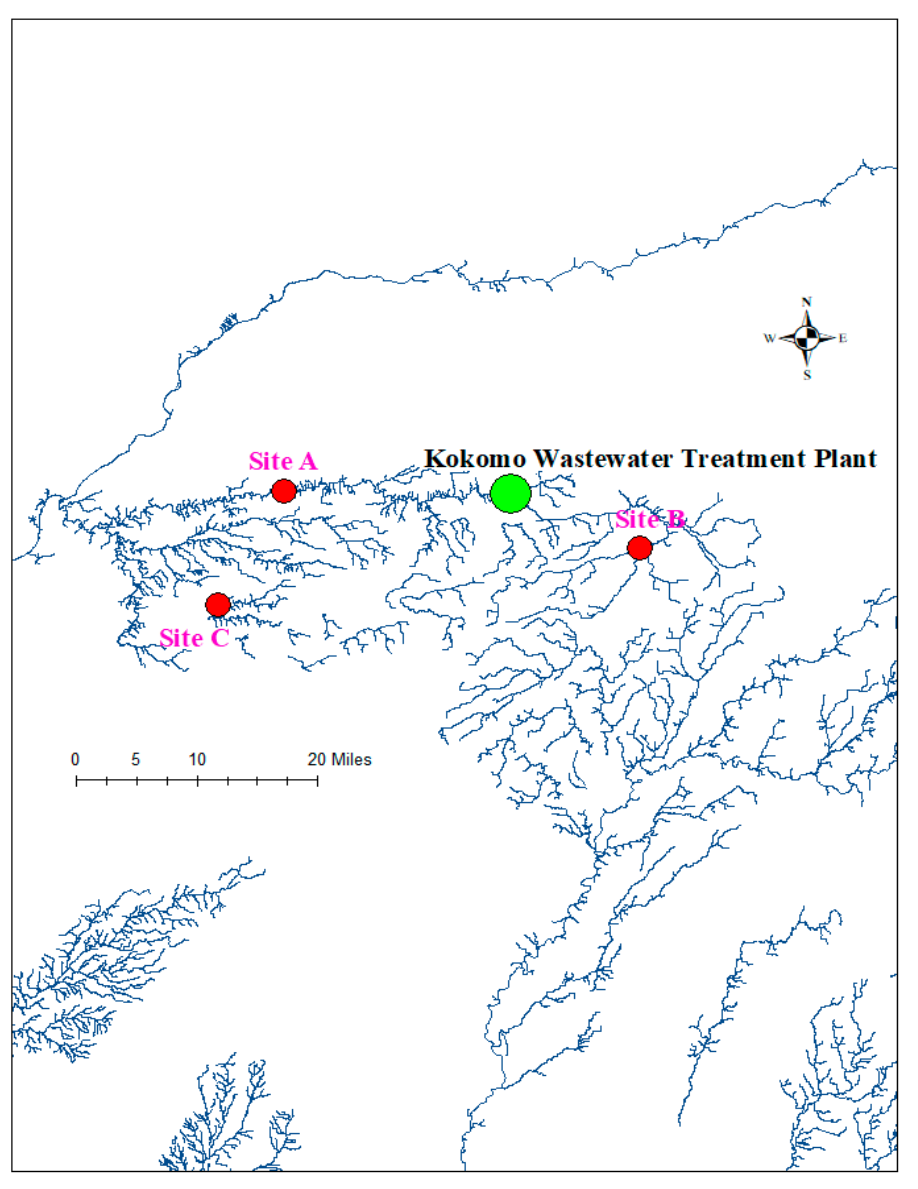
Figure 2. A map layer of impaired water bodies in Indiana. The locations of the three sampling sites within the Wildcat Creek watershed are represented by the letters A, B, and C. Site A is the Wildcat Creek (Carrol County), Site B is the Mud Creek (Tipton County), and Site C is the Kilmore Creek (Clinton County). This map was created using ArcMap in ArcGIS version 10.5.1. The map layer and associated metadata were downloaded from https://maps.indiana.edu/previewMaps/Hydrology/Water_Quality_Impaired_Waters_303d_2016.html on 15 June 2020. (Credits: Indiana Department